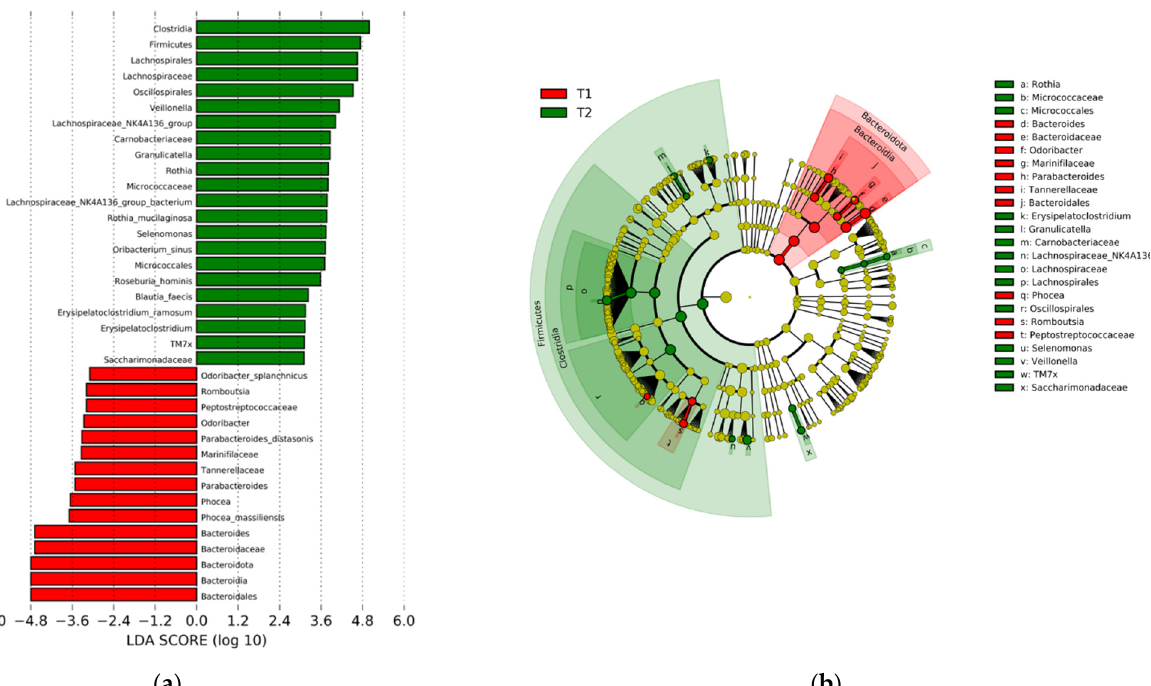
Figure 2. Microbial shifts across the intervention among the most abundant taxa. ( a ) Bacterial taxa significantly increased in subjects at T1 (red) versus T2 (green) as identified by Linear discriminant analysis Effect Size (LEfSe) analysis; ( b ) bacterial clades of the respective bacteria.